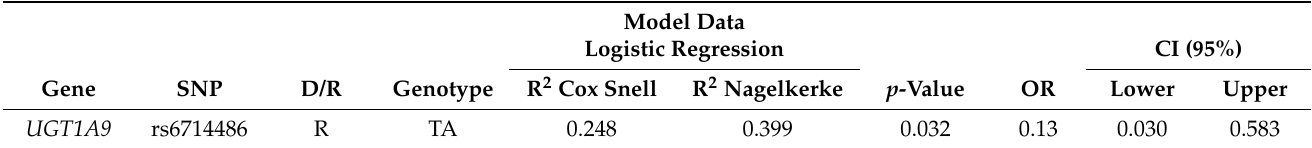
Table 4. Pharmacogene variants significantly associated with tumor incidence after FDR calcula- tion employing the p -values of selected variables in cancer risk and exitus studies by logistic and Cox regression.